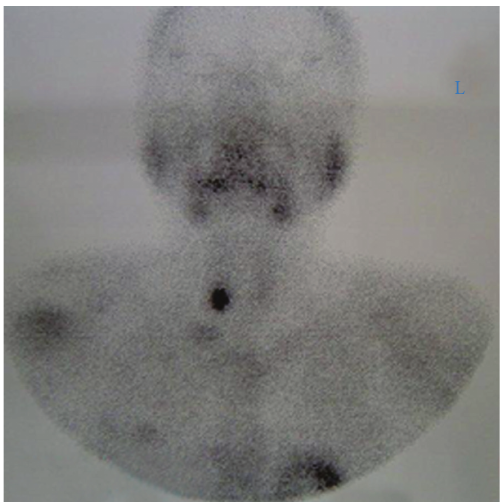
Figure 2: The T99m nuclear scan a focal and persistent active spot at the lower pole of the right thyroid gland, consistent with parathyroid